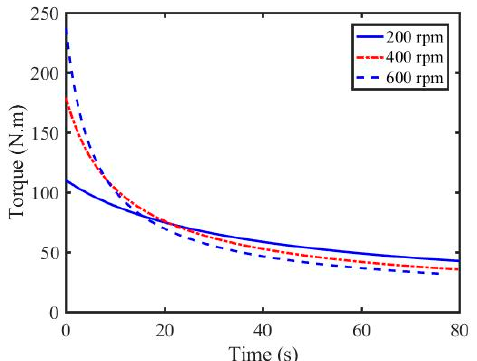
Figure 4. Internal temperature of the VC.